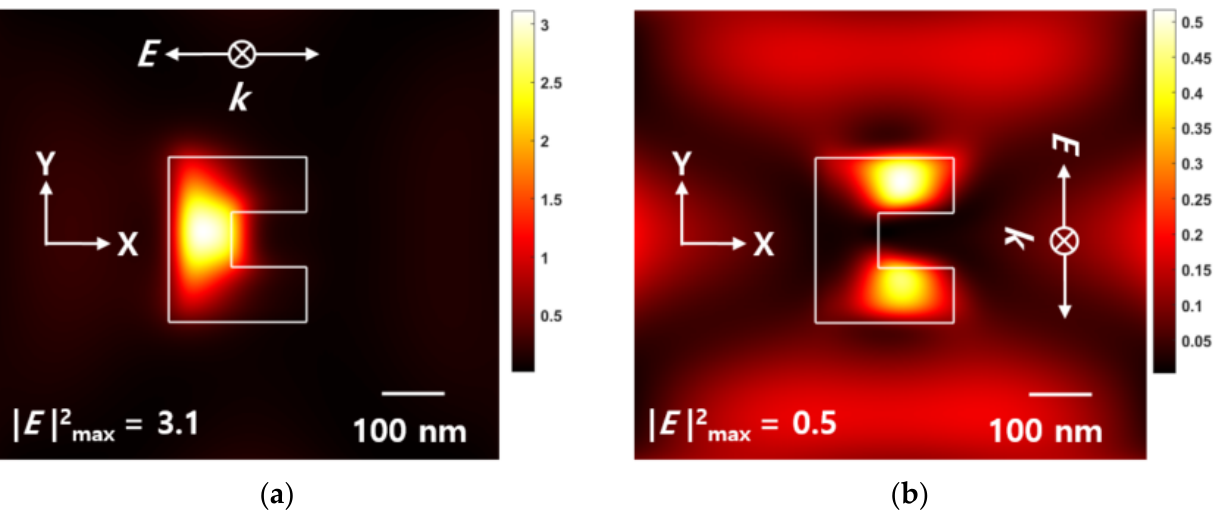
Figure 9. Electric field intensity | E | 2 distribution in the x-y plane of ridge-type nanoaperture with Au NPs array deposited media from the bottom of the ZnS-SiO 2 layer: ( a ) x -polarized light; ( b ) y - polarized light.